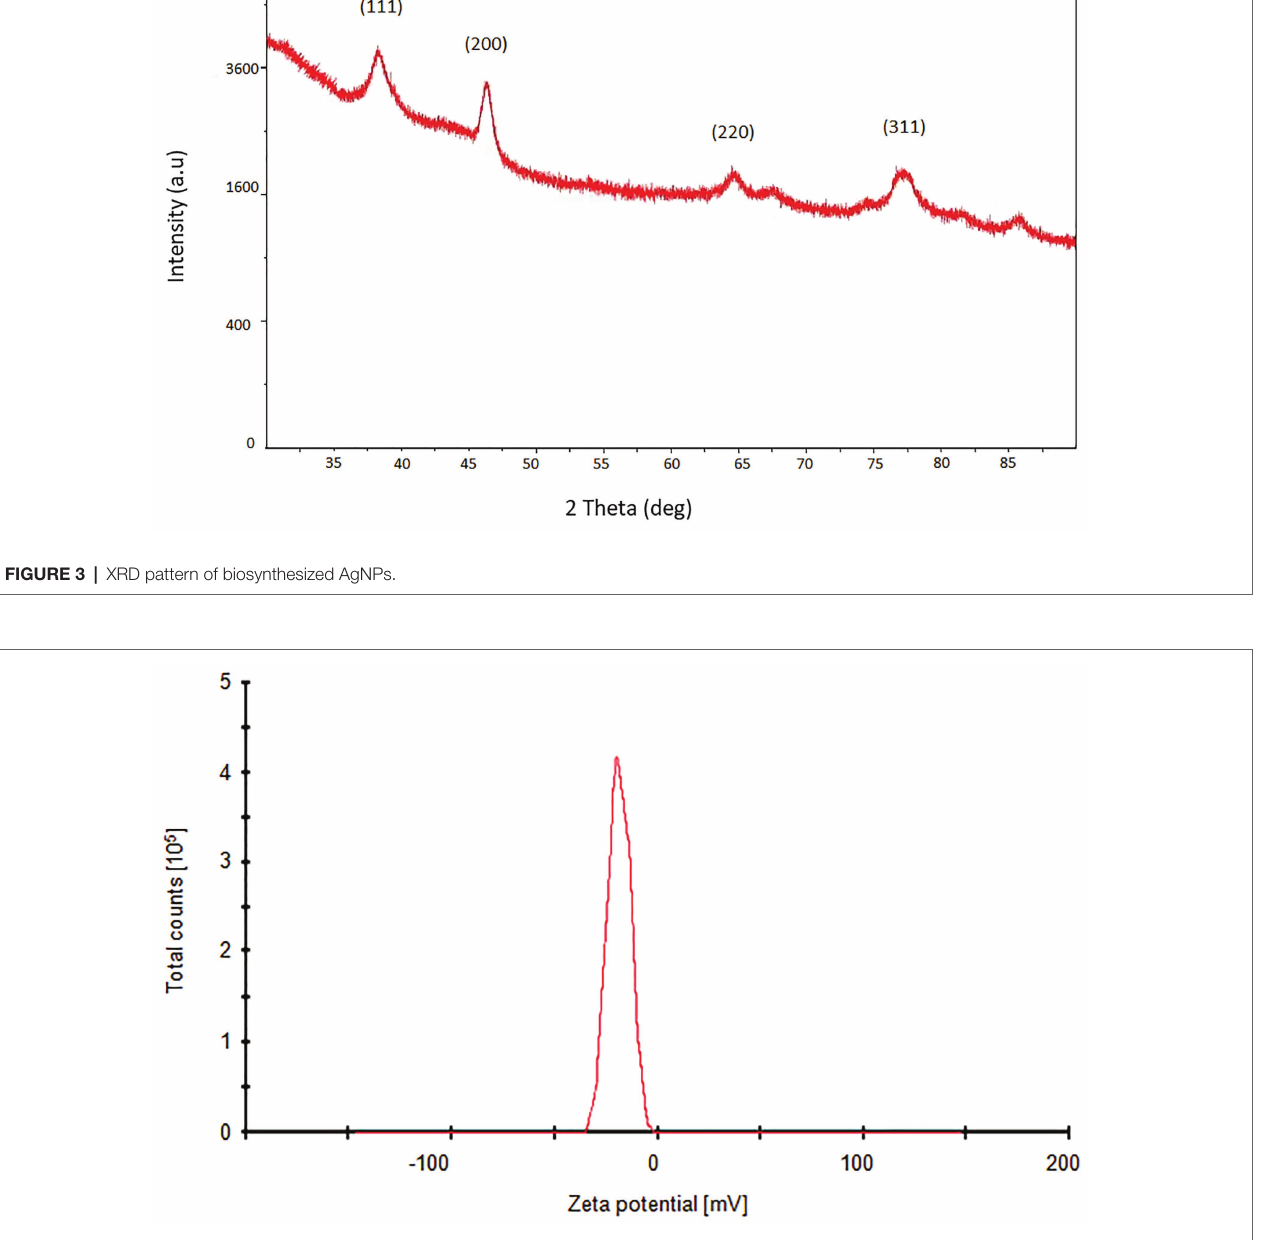
FIGURE 4 | Zeta potential graph of biosynthesized